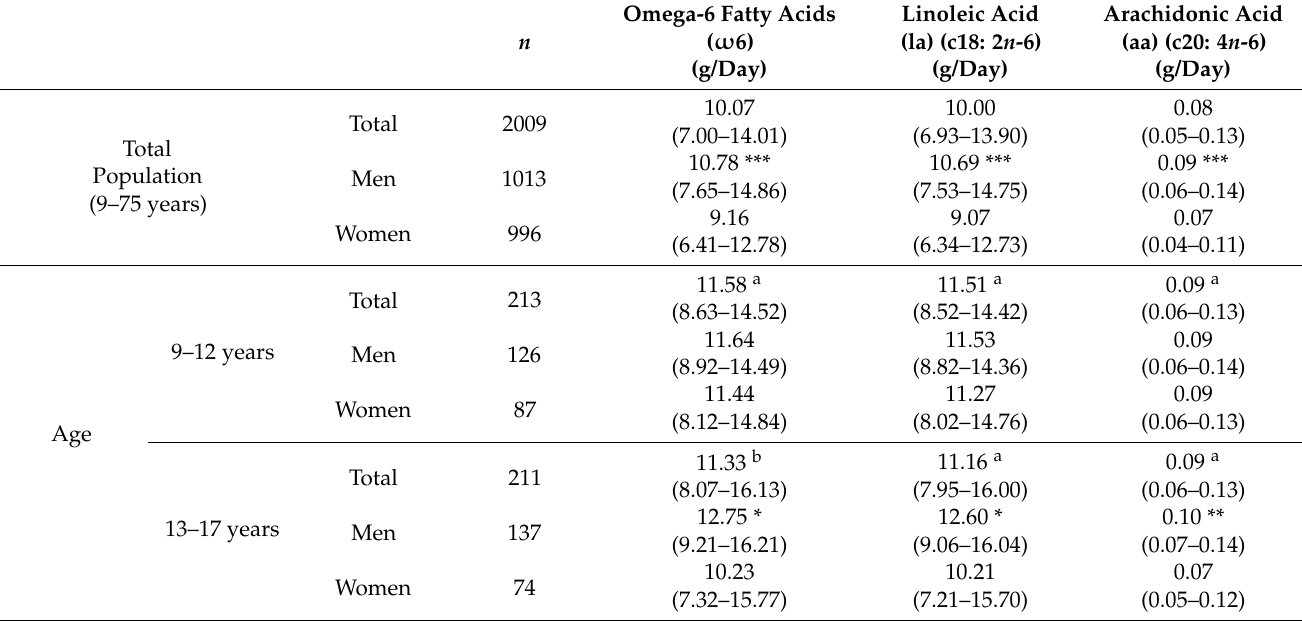
Table 3. Omega-6 fatty acid dietary intake among the ANIBES Study